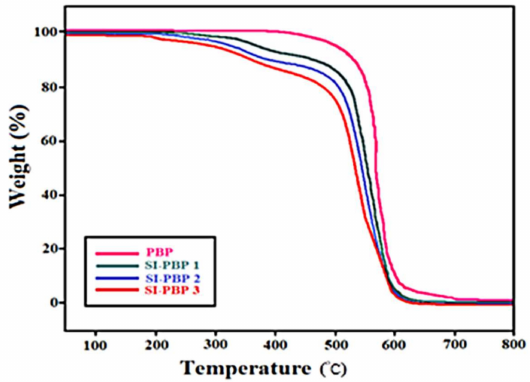
Figure 5. Thermo-oxidative stabilities of PBP and SI-PBP